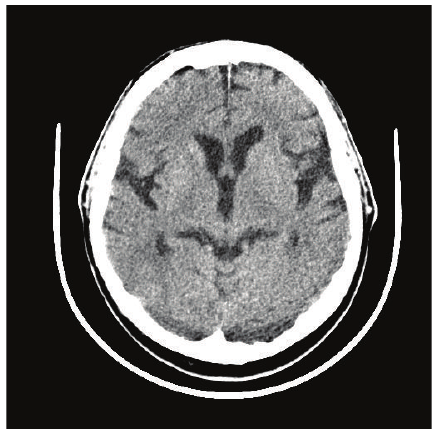
Figure 1: CT slice to extract ventricles.